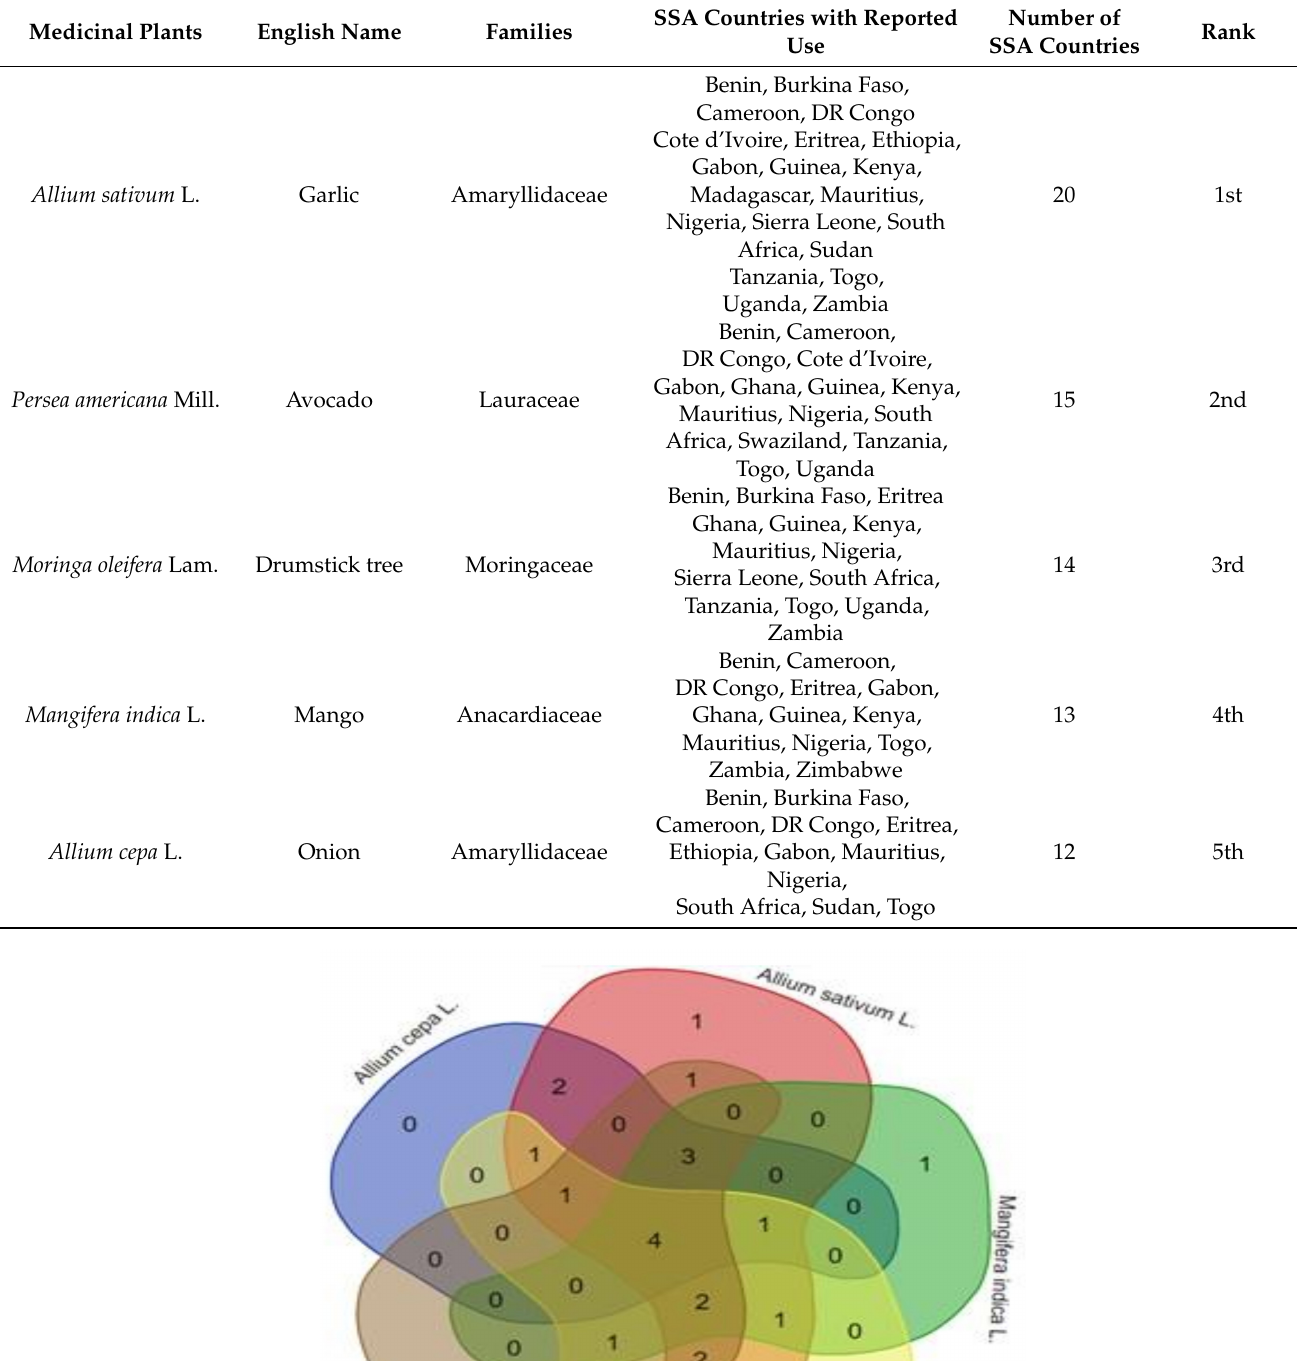
Table 3. Details of five most preferred medicinal plants in sub-Saharan African countries for the treatment of cardiovascular diseases and their associated risk factors.